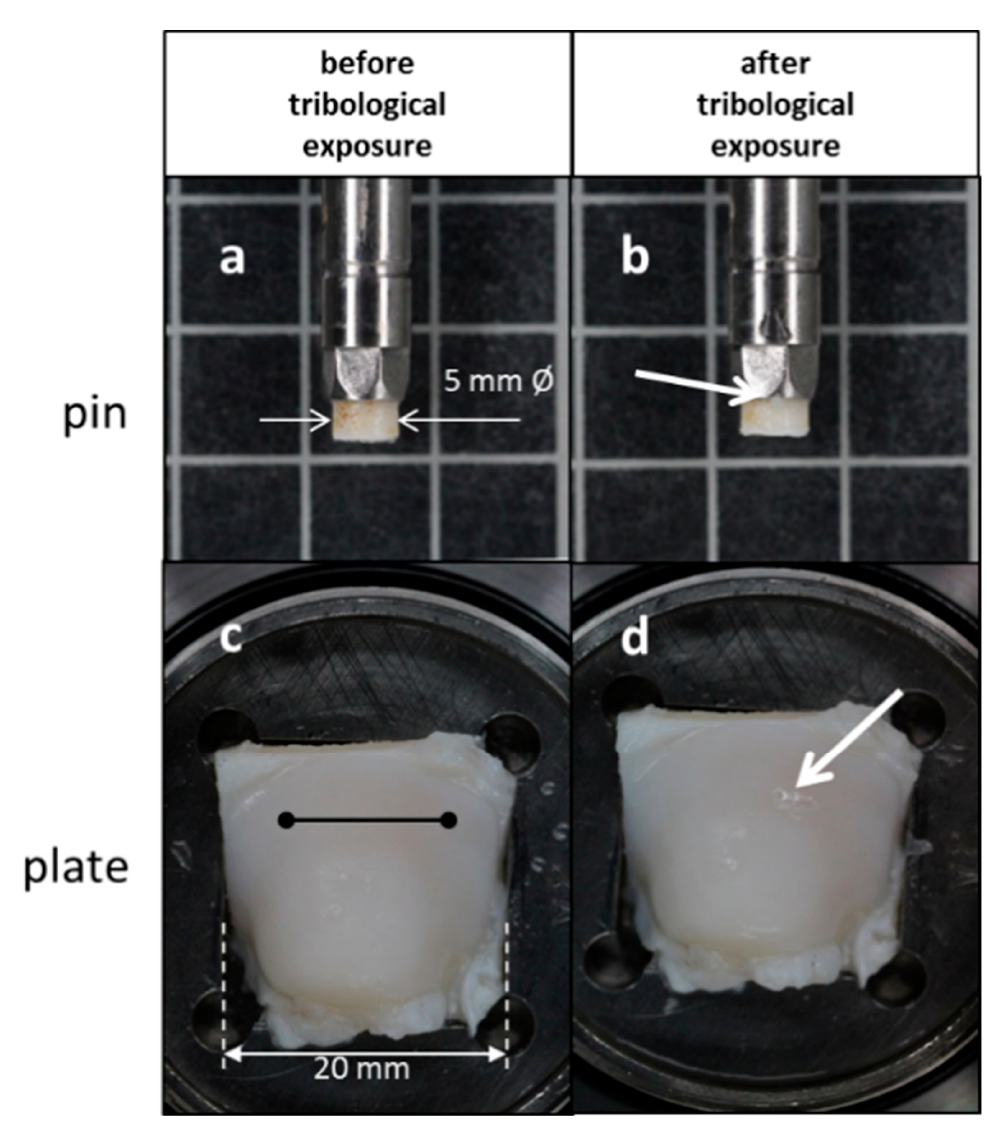
Figure 1. Pin and plate pair specimen from the E48w group before and after tribological exposure. A CoF of 0.0287 was calculated in the mean. ( a ) The pin is fixed in the pin holder. A thin layer of spontaneously regenerated tissue is visible on top of the pin after the healing period of nearly 1 year. ( b ) A small shred of a mucous consistency that detached itself from the layer stuck to the rim of the pin holder (arrow). ( c ) Top view on the plate originating from the lateral tibia plateau. The trajectory of the pin is indicated by the black line. The analysis of the uneven surface of the section where the pin moved revealed slope angles ranging from 0.00° to 7.65° with a median of 2.16°. ( d ) After the tribological exposure, some irregularities of the surface were noticeable (arrow). The height loss (HL) was determined with 0.35 mm in the mean in the middle of the trajectory after 1 h of reciprocating shear stress. Note the somewhat different magnifications of the figures.